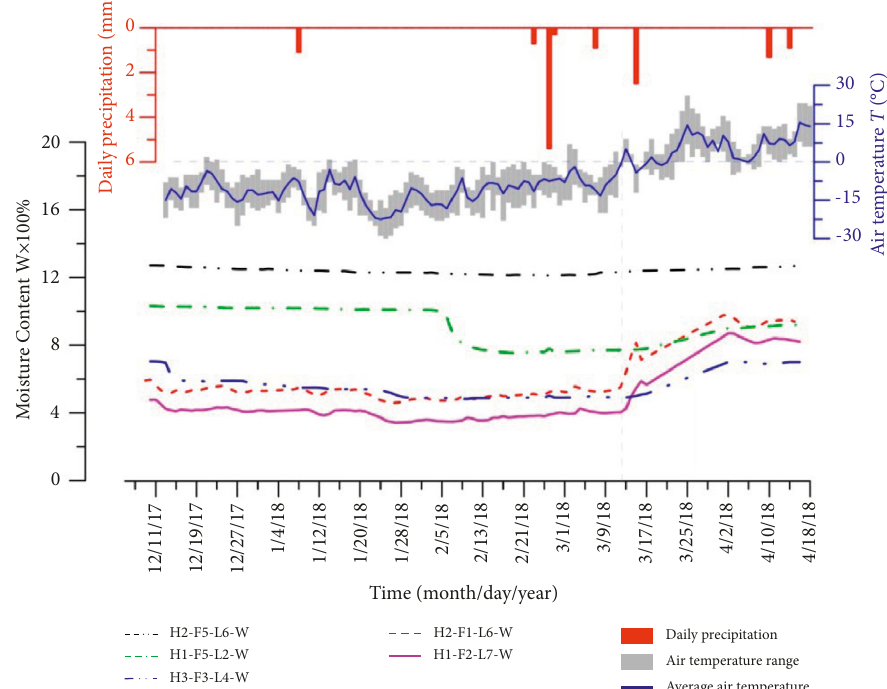
Figure 5: Curves of soil moisture of each layer in the roadbed under climatic conditions.